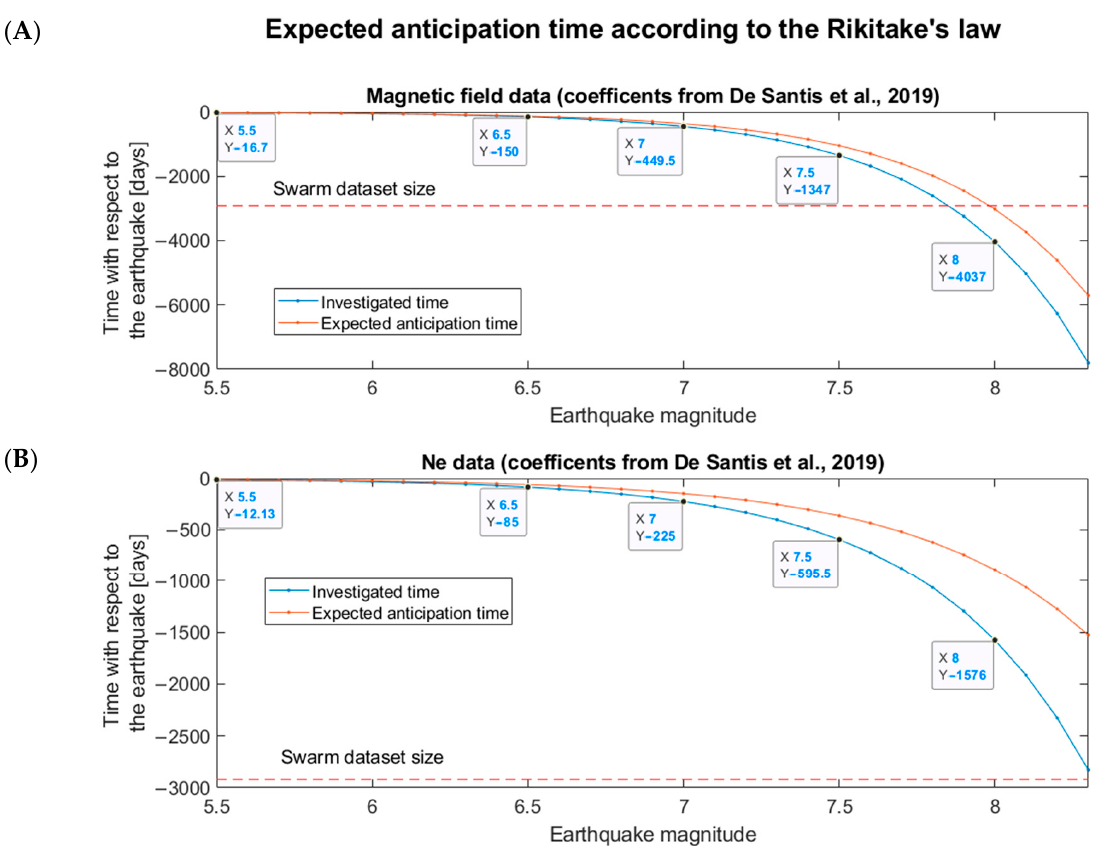
Figure 6. Expected anticipation time of magnetic field ( A ) and Ne ( B ) anomalies with respect to the earthquake, using the Rikitake law [37] and considering the coefficients found by De Santis et al. [29] for 4.7 years of Swarm data (orange line). The investigated time window is shown as a blue line, and the 8-year Swarm dataset maximum size is shown as a dashed red line. The data tips provide the time that has been analyzed before a specific magnitude earthquake, applying Equation